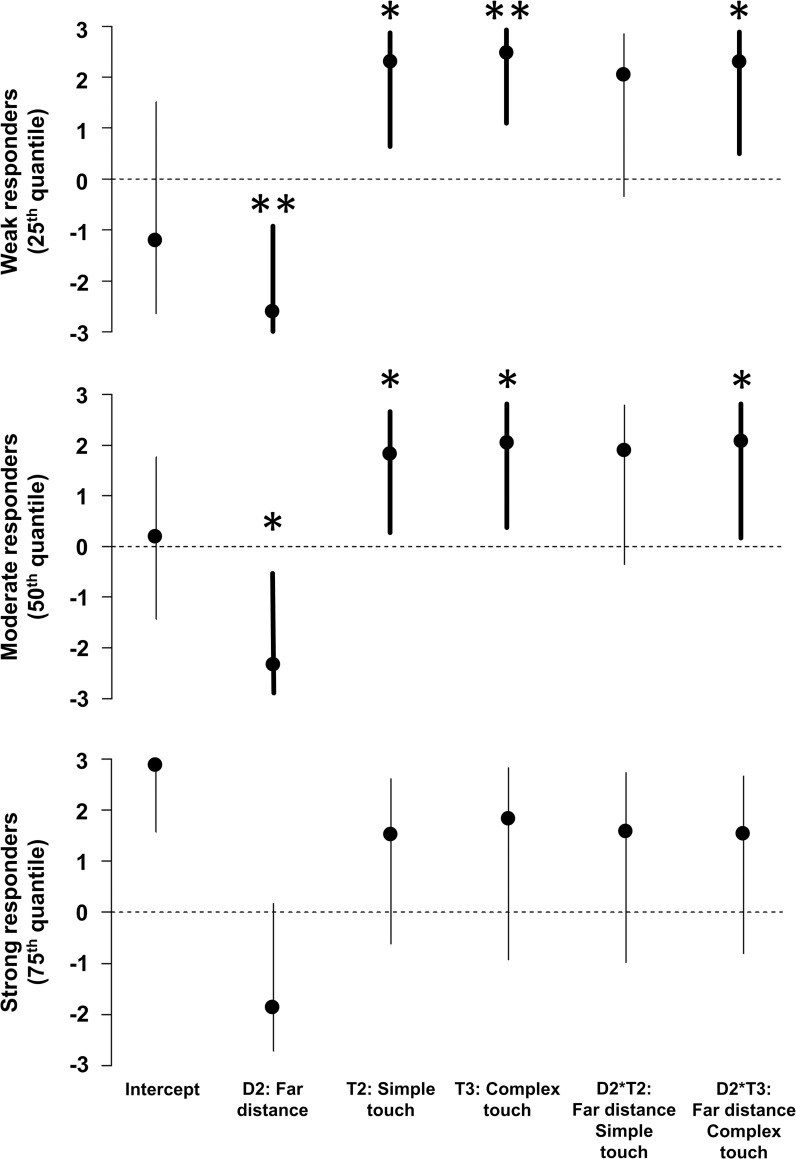
Effects on subjective RHI strength of distance, touch availability/complexity, and their interaction.Effects were estimated by a linear quantile mixed model (LQMM) at three tested percentiles (25th–weak responders; 50th–moderate responders, 75th–strong responders). For main effects, coefficients represent expected change in the outcome variable (RHI strength) for each unit of change in the predictor when the interacting variable is at the baseline level (e.g., expected change with increased distance (D2) when no touch (T1) was applied during illusion elicitation). For interactions, the coefficients reflect the difference in the change of RHI strength with distance (D2), compared to the change when the interacting variable is at the baseline level (T1) [44]. For example, at the 25th percentile, attenuation of the RHI with distance in the complex touch condition (T3) is 0.22, compared to 2.57 at the baseline level (T1)—a decrease of 2.35 (as shown by the D2:T3 coefficient). Taken together, these results show that complex tactile information counteracted the attenuation of RHI strength caused by increased distance only among weak and moderate responders. The simple touch condition showed similar yet non-significant tendencies, which suggests that simplified tactile stimulation may be less potent in counteracting the attenuating effect of increased distance. Bold lines show significant effects. ** p < 0.01, * p < 0.05. (Note that the unequal confidence interval bounds are due to the non-linear back-transformation to the original scale).